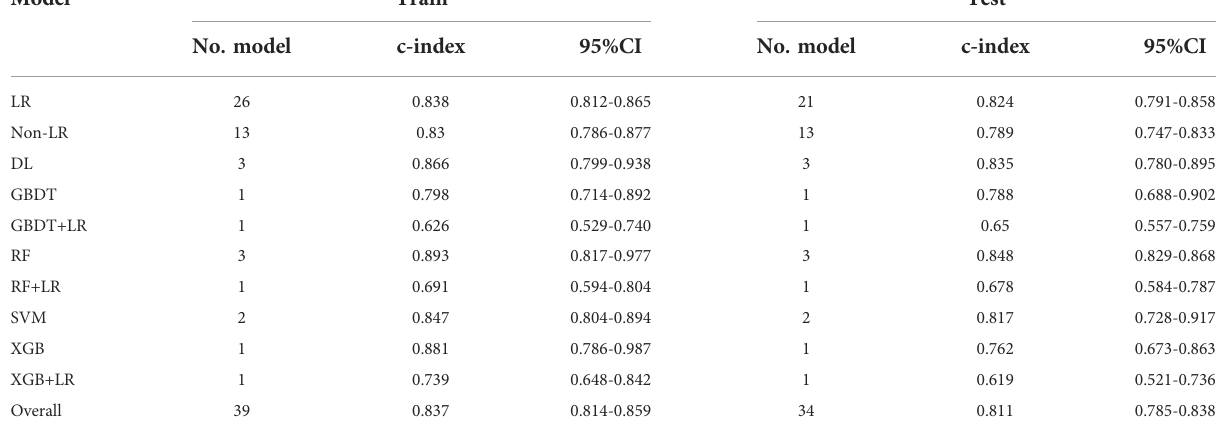
TABLE 3 c-index for prediction models in gastric cancer